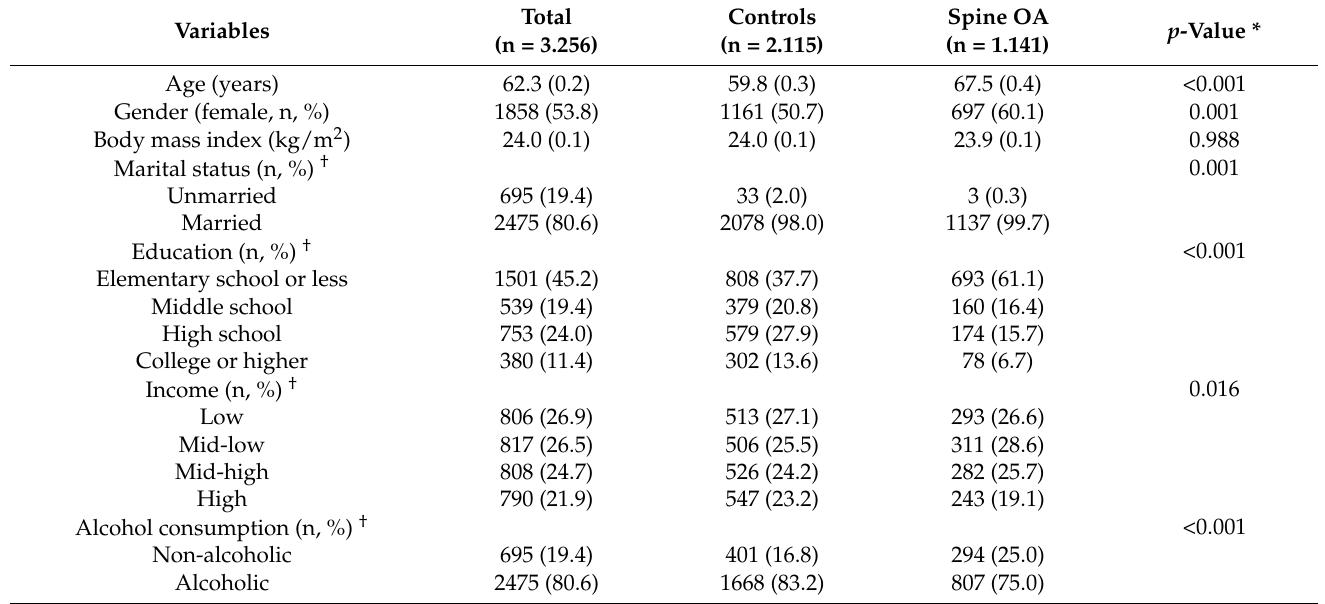
Table 1. Comparison of variables between controls and subjects with spine OA (n =